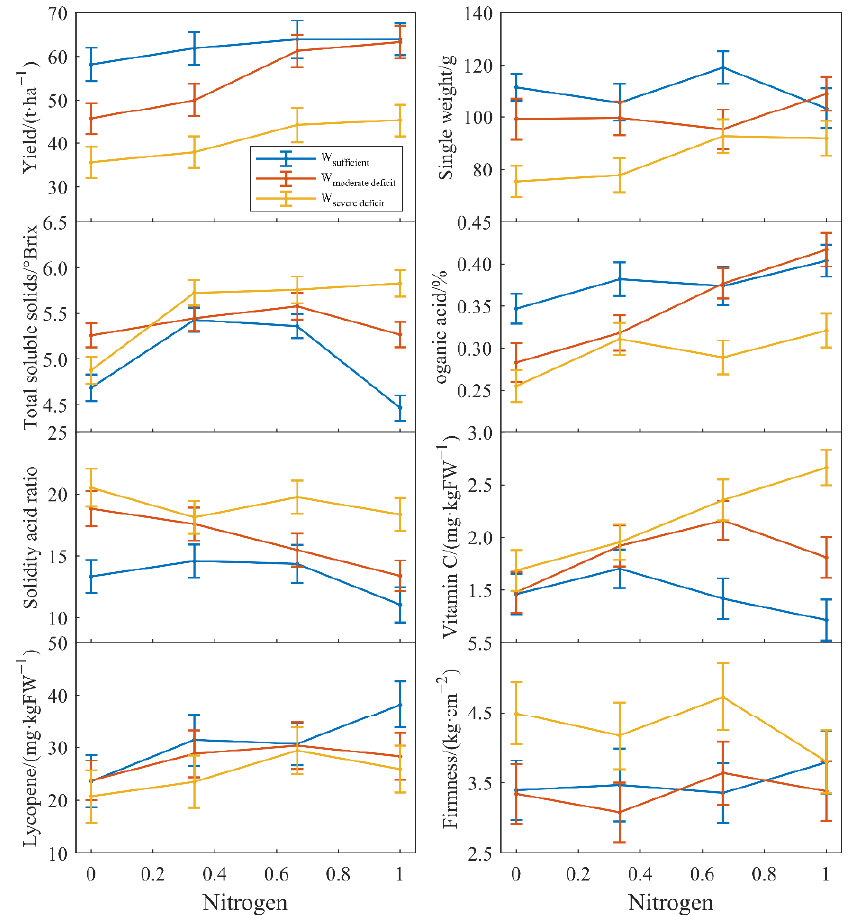
Figure 3. The interaction effect of water and nitrogen on yield, single fruit qualities parameters and comprehensive fruit quality in the first and second seasons of 2019. Notes: the vertical axis is the estimated marginal mean value of each parameter; the horizontal axis is the gradient of nitrogen including full nitrogen, mild stress, medium stress and heavy stress.